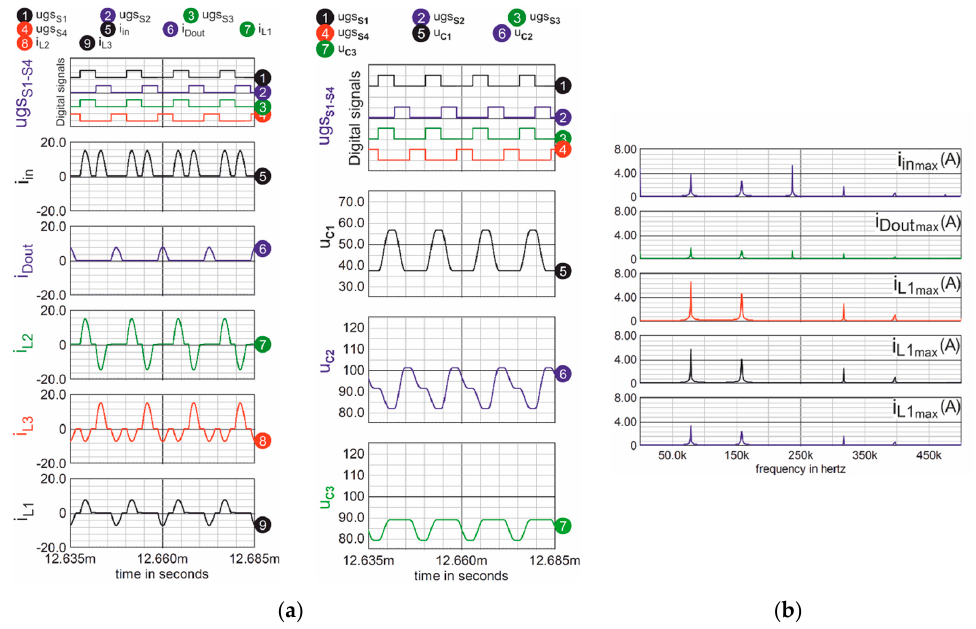
Figure 4. Steady-state operation of the LCSCVMa converter under switching strategy C2: ( a ) waveforms of the gate to source signals of transistors (presented with level shift), input current (in amperes), and voltages (in volts) on capacitors C 1 , C 2 , and C 3 . ( b ) Spectrum of the input current, and currents of switched capacitors and output capacitor. The results were obtained with the use of ICAP/4 simulation software.